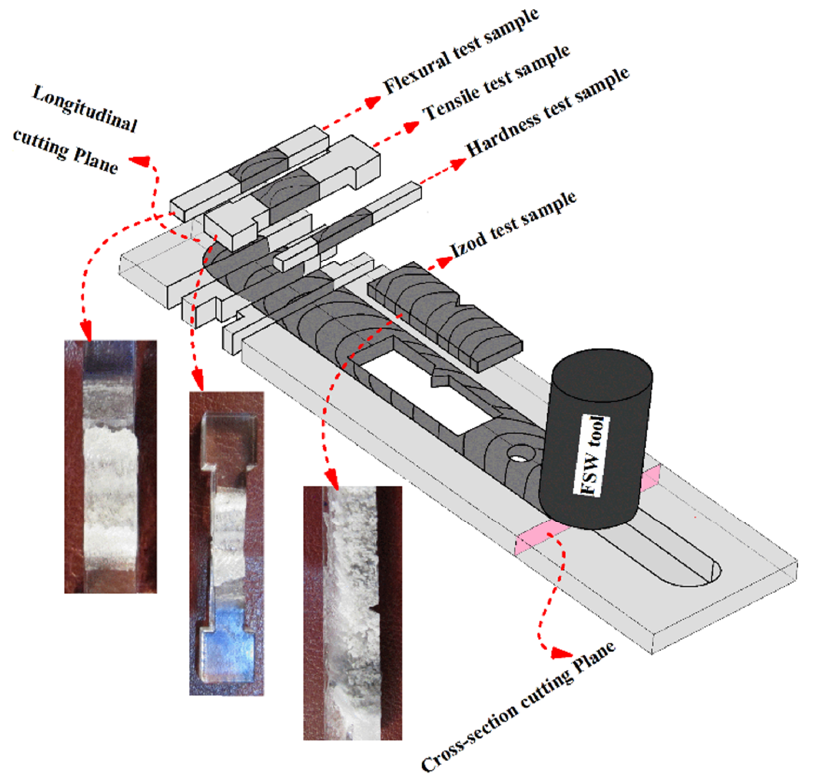
Figure 8. Linear friction stir welding test sample [24].